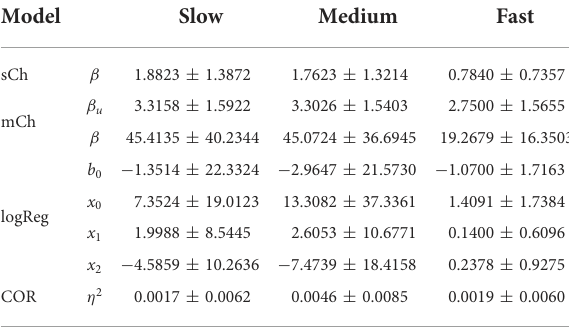
TABLE 1 Mean model parameters averaged across subjects for the three conditions slow, medium, and fast. Model Slow